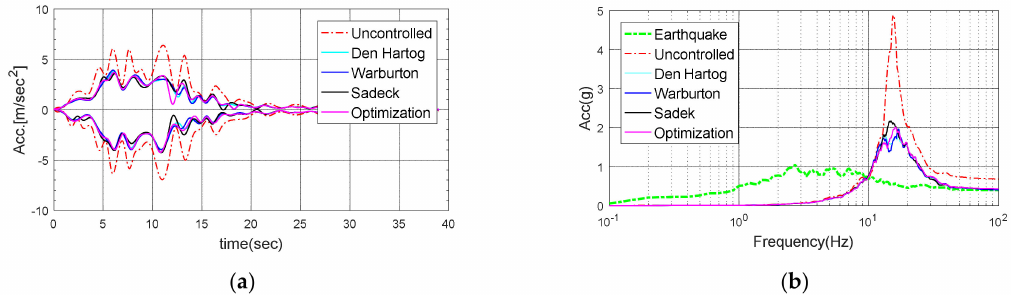
Figure 27. Response of the electrical cabinet subjected to Imperial Valley-06: ( a ) Time history; ( b ) Response